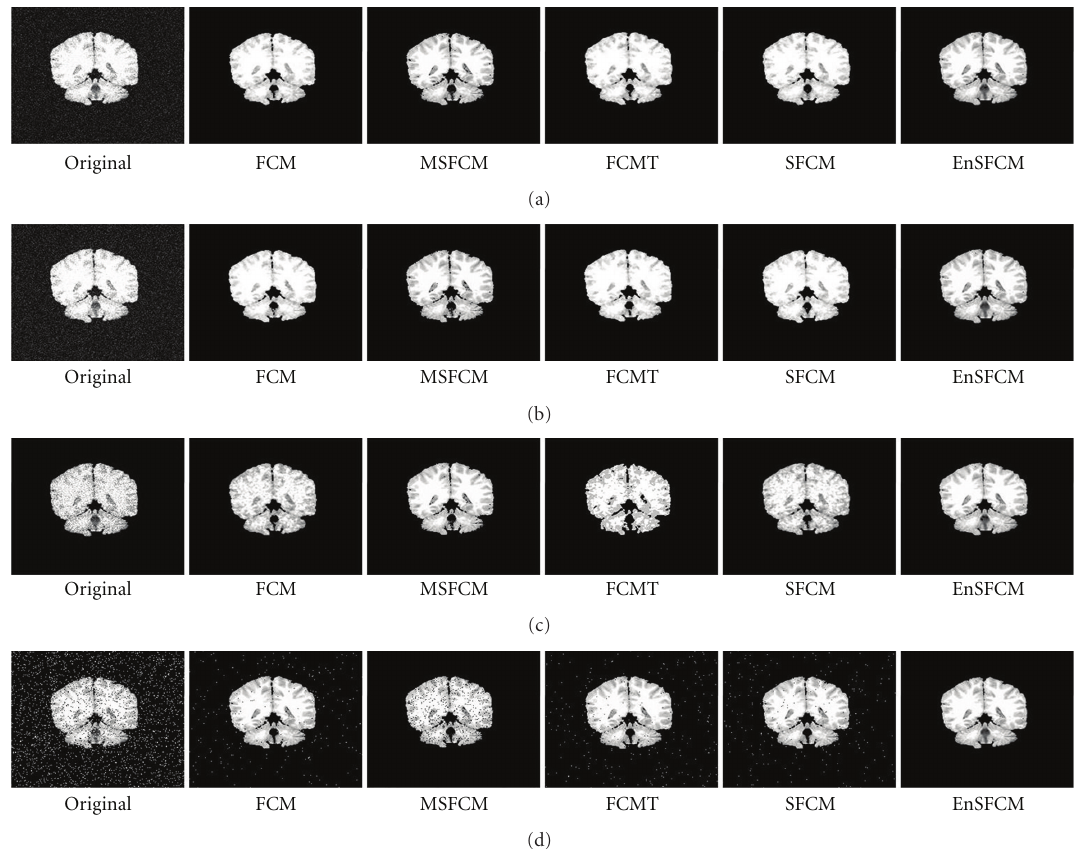
Figure 4: Segmentation results in noisy environment. (a) 8% Gaussian noise, (b) 10% Gaussian noise, (c) speckle noise, (d) 10% salt and pepper noise, and (e) 12% salt and